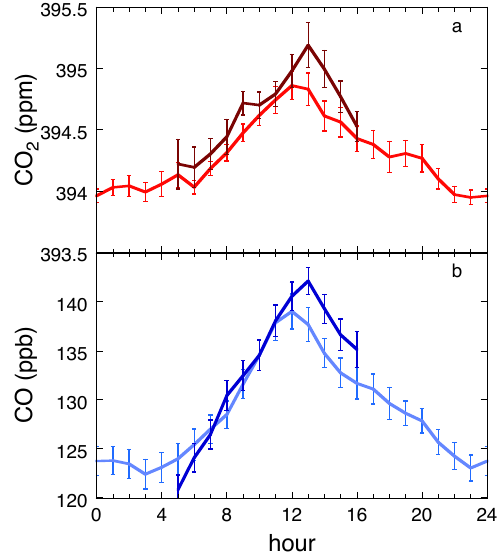
Fig. B1. Comparison of calculated column (a) CO 2 (red) and (b) CO (blue) mixing ratios at the CalNex-LA site on 15 May–15 June 2010 (lighter colors) with those measured on 1 May–22 June 2008 at JPL by FTS (darker colors), as part of the Total Carbon Column Observing Network (TCCON; Wunch et al., 2011; TCCON data (version GGG2012) were obtained from the TCCON Data Archive, operated by the California Institute of Technology, from the website at http://tccon.ipac.caltech.edu/). The TCCON mixing ratios were offset to match the CalNex-LA values (6ppm CO 2 and 20ppb CO added). Note that CO 2 mixing ratios vary ∼ 1ppm and CO ∼ 15– 20ppb with peaks at 12:00 to 13:00 for both sets of measurements. The time period averaged for the TCCON data is longer than for the CalNex-LA data in order to have the same number of data points for the two data sets ( n = 32, on average). Error bars indicate standard